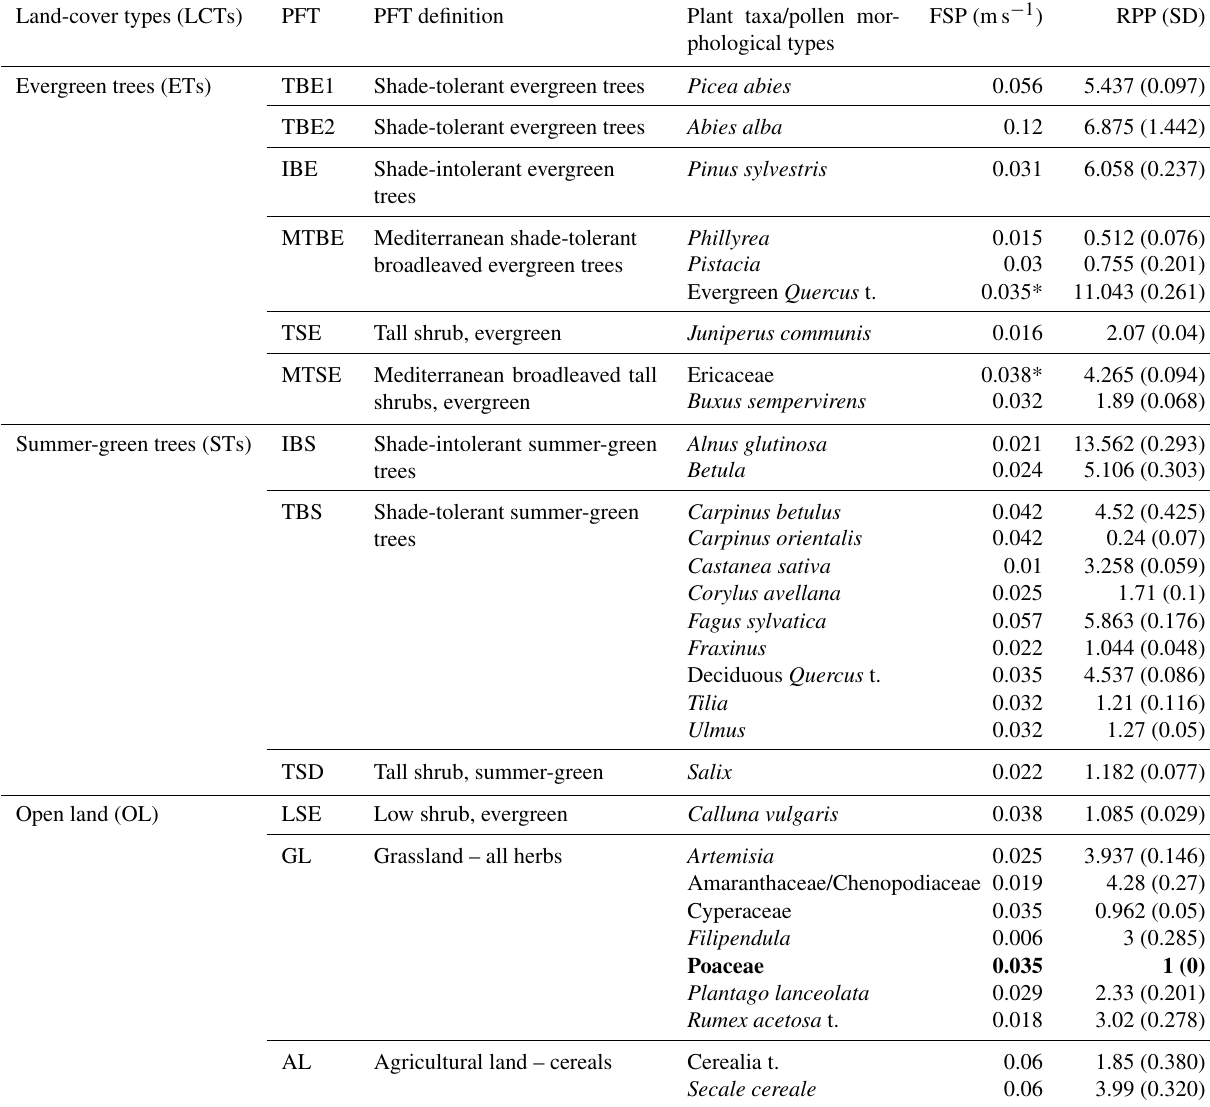
Table 1. Land-cover types (LCTs) and plant functional types (PFTs) according to Wolf et al. (2008) and their corresponding pollen morpho- logical types. Fall speed of pollen (FSP) and the mean relative pollen productivity (RPP) estimates from the new RPP synthesis (see Sect. 2.3 and Appendices A–C for details) with their standard deviations in brackets (see text for more explanations). Land-cover types